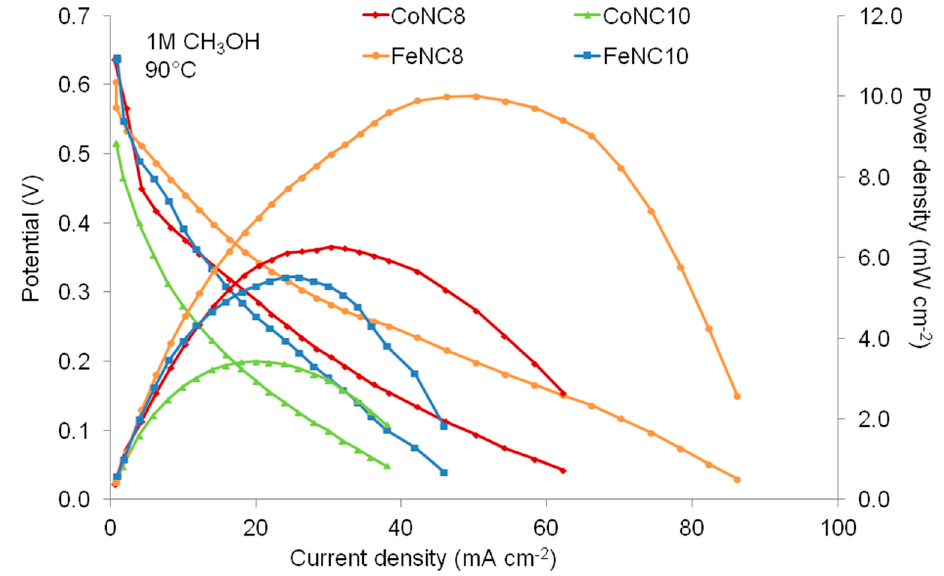
Figure 9. Polarization and power density curves obtained for CoNC8, CoNC10, FeNC8, and FeNC10 at the cathode of the direct methanol fuel cell (DMFC) by using a 1 M methanol concentration at 90 °C.